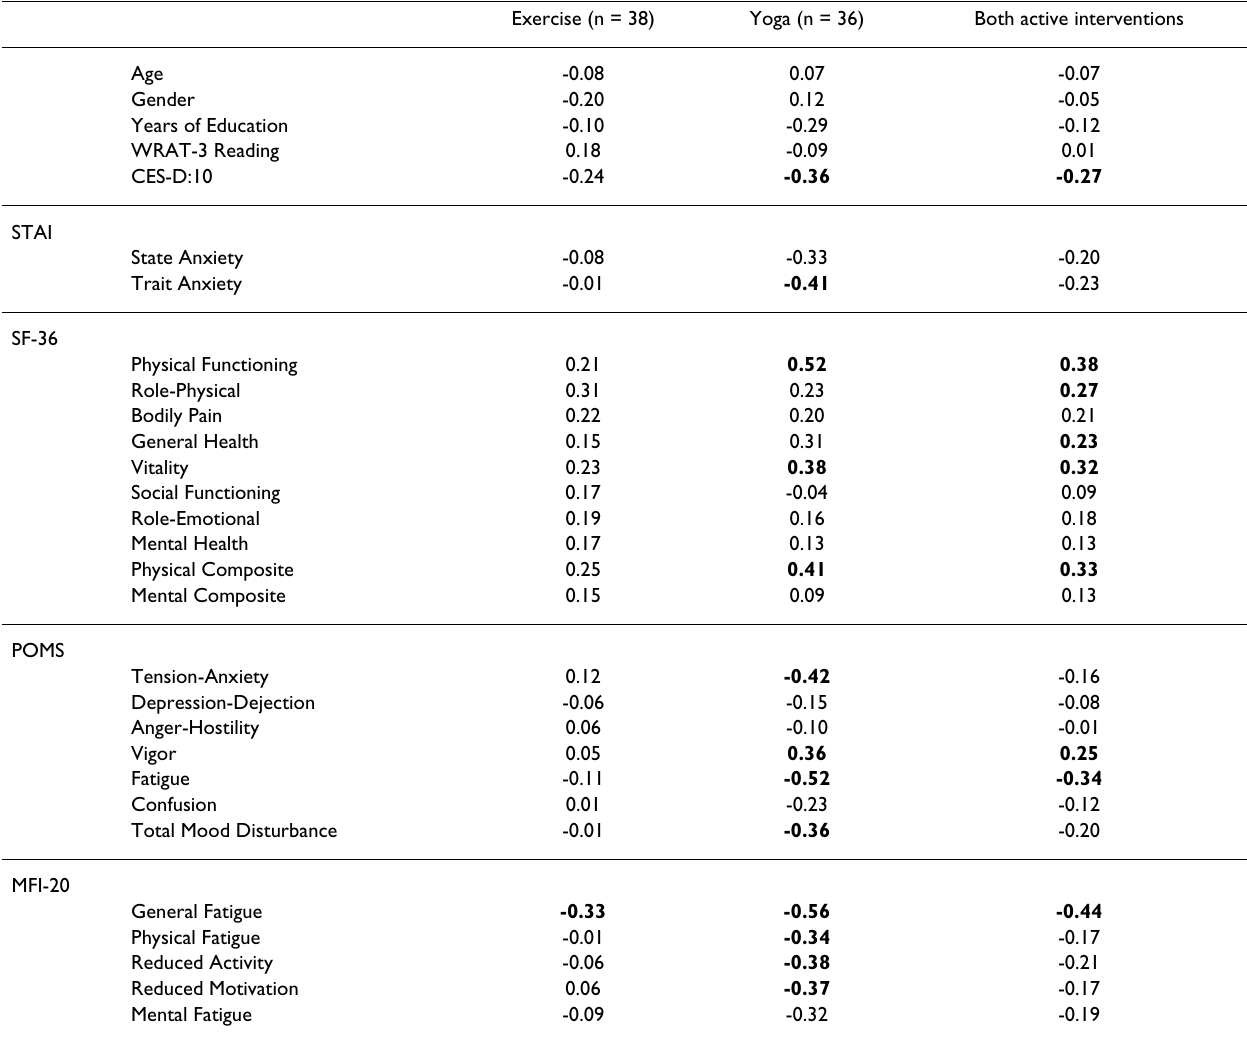
Table 2: Correlations of adherence (Percent Classes Attended) and baseline variables among study